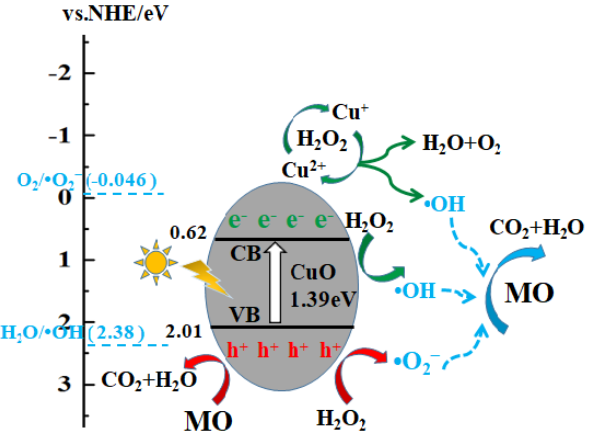
Figure 11. Band-gap structure of CuO and photocatalytic mechanism.